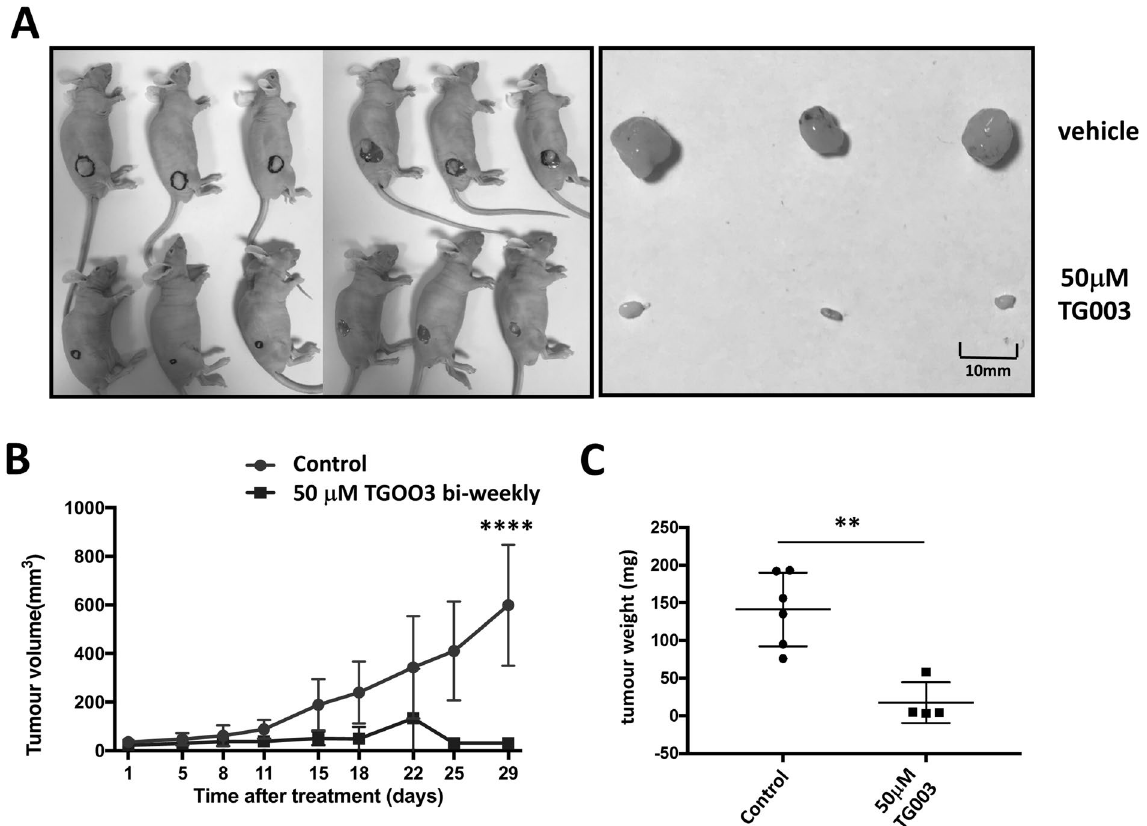
Figure 5. Effect of TG003 on xenograft growth . One million PC3 cells were injected subcutaneously into cohorts of six CD1-nude mice and tumour volumes measured over a period of 29 days, comparing vehicle control versus 50 µM TG003. ( A ) Image of the excised tumours; ( B ) tumour volumes measured in in mm 3 and ( C ) tumour weight in mg. Tumour sizes were statistically different, two-way ANOVA. ** p < 0.01; **** p < 0.0001.